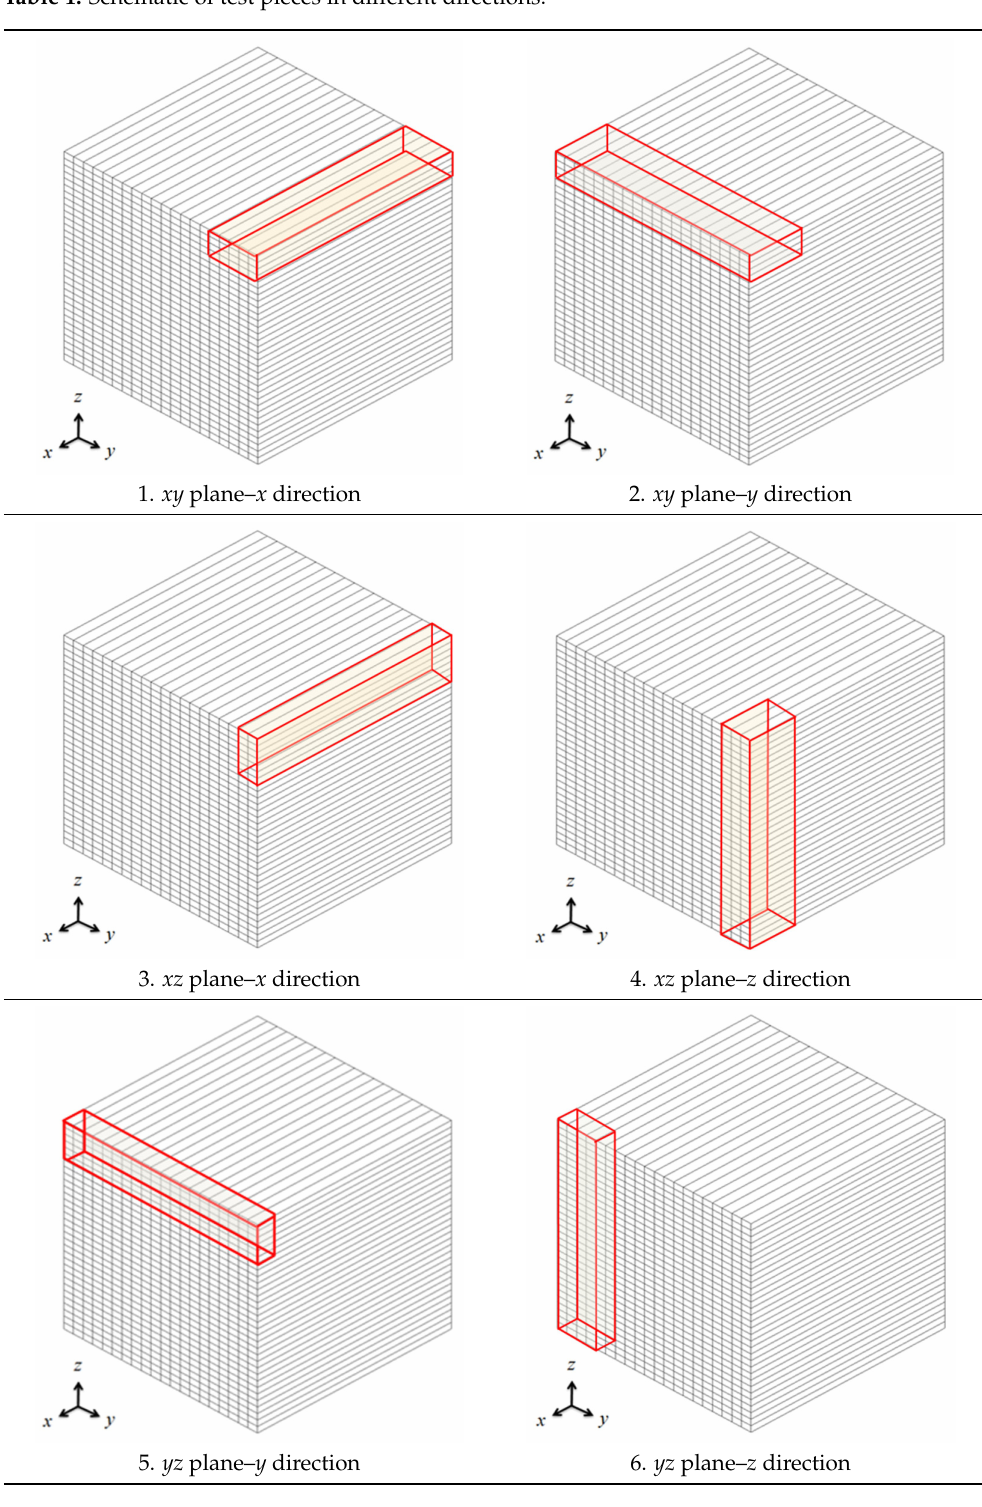
Table 1. Schematic of test pieces in different